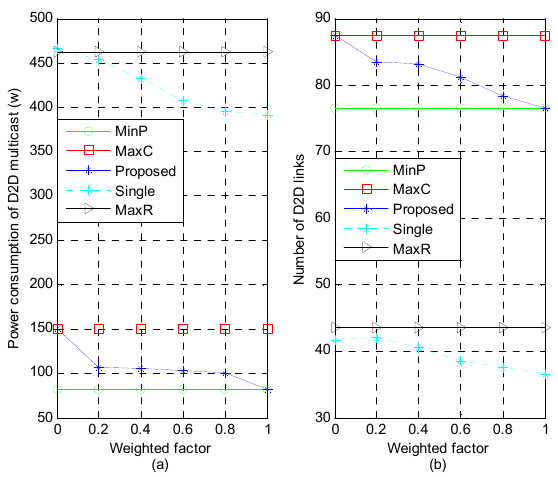
Figure 2. Power consumption and number of D2D links versus weighted factor: ( a ) Impact of weighted factor on power consumption; ( b ) Impact of weighted factor on system capacity.